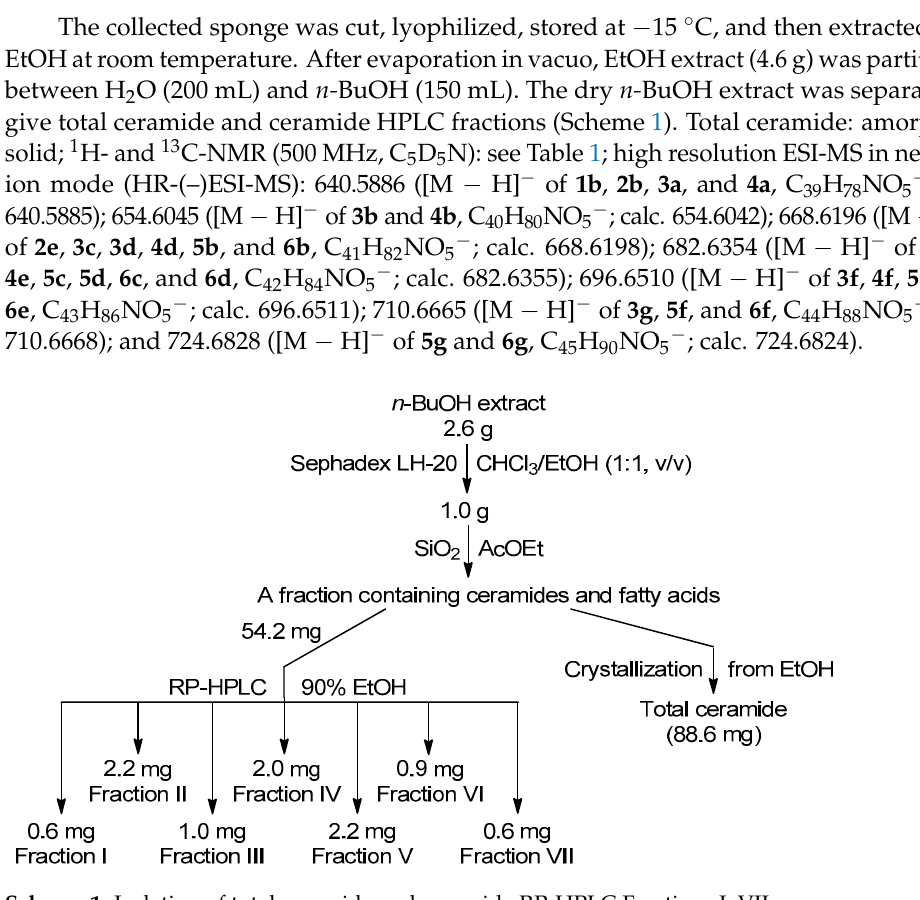
Table 1. 1 H- (700 MHz) and 13 C- (125 MHz) NMR data * for the total ceramide of M. clathrata (C 5 D 5